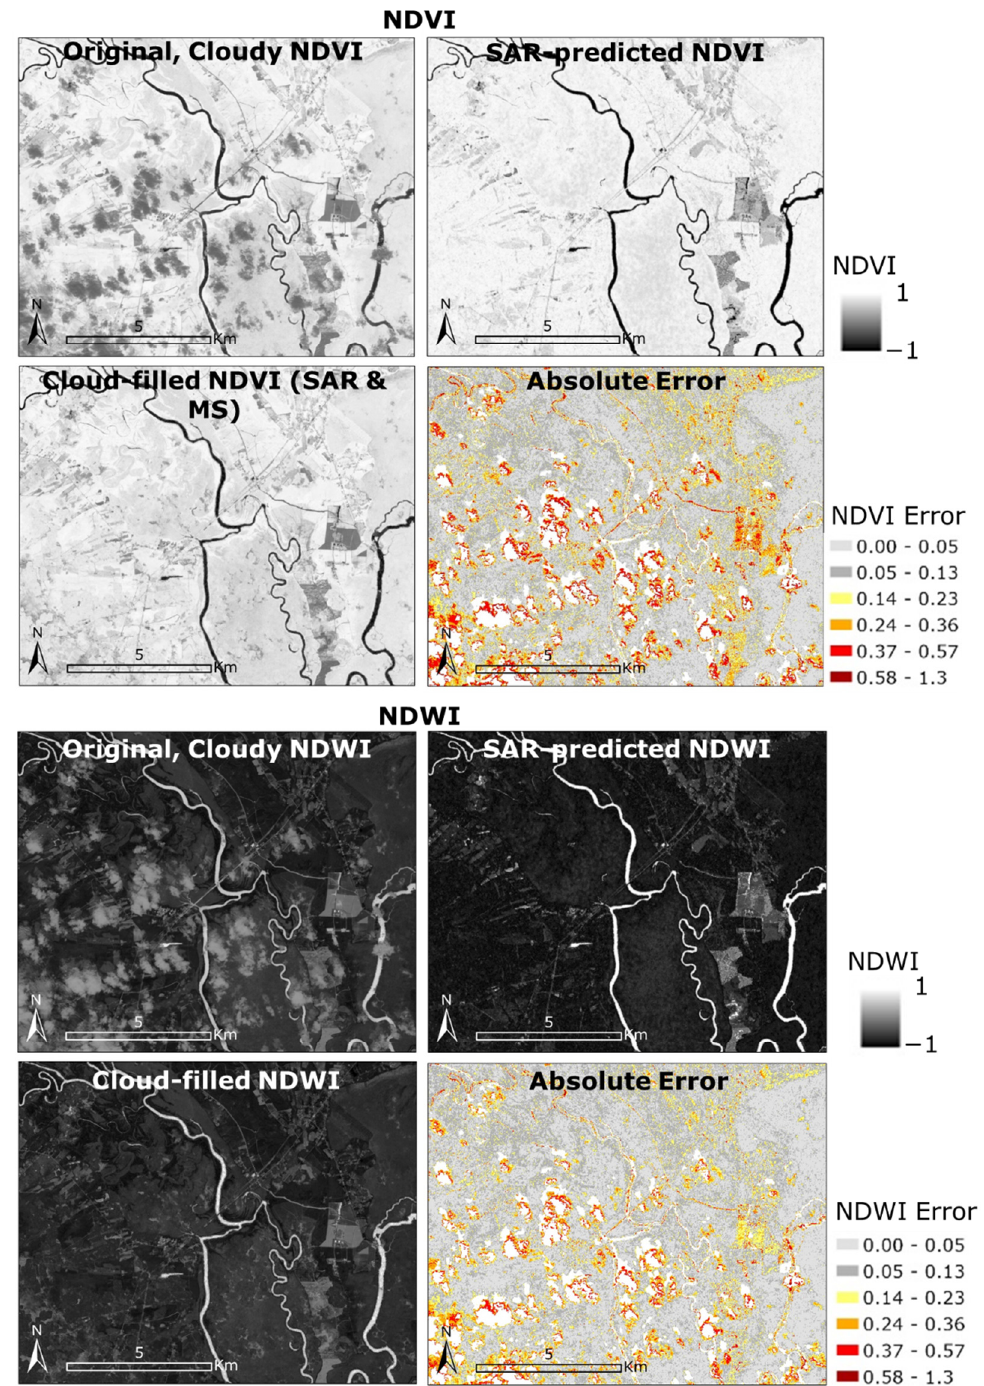
Figure 5. This view zooms in on a portion of the study area containing errors for NDVI at the top and NDWI at the bottom. The first sub-plot shows the original NDVI which contains clouds and cloud shadow, the 2nd subplot (top-right) shows the NDVI values estimated using SAR, the 3rd subplot (bottom-left) shows the original NDVI with cloud and cloud shadow pixels gap-filled with SAR-predicted NDVI values and the 4th subplot (bottom-right) shows the absolute error per pixel. Most errors are observed adjacent to clouds or over agricultural lands with mid-range NDVI or NDWI.